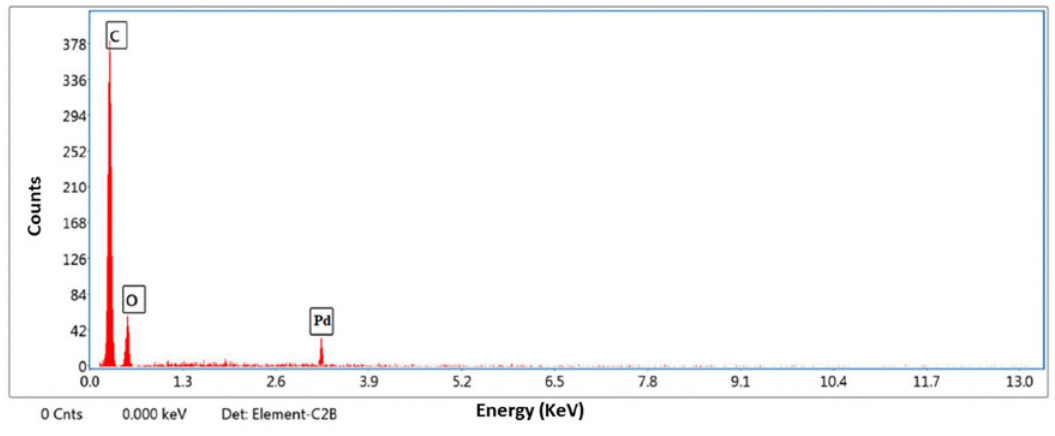
Fig. 3. EDX spectrum of Pd supported MWCNTs